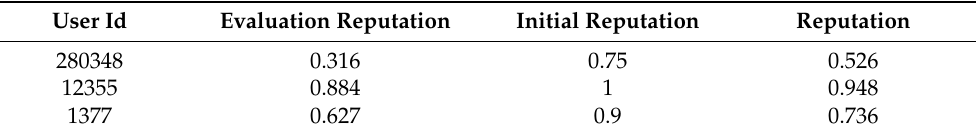
Table 5. Reputation of user id 280348, 280348, and